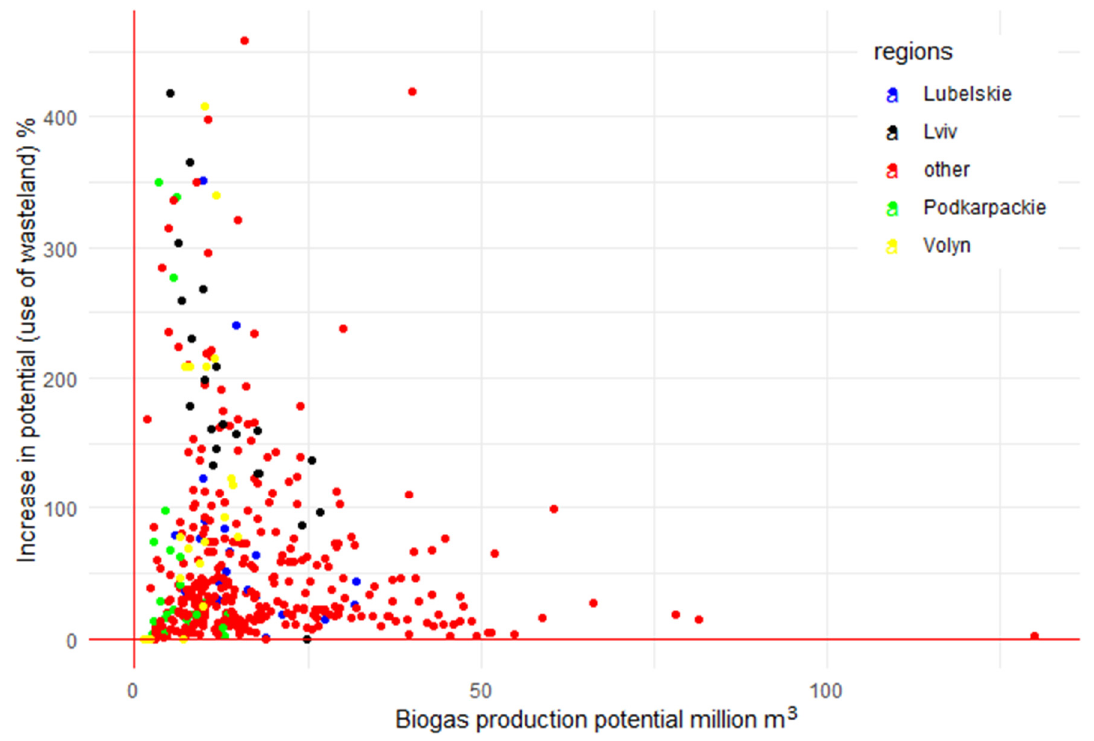
Figure 6. The basic potential of biogas production at the powiat and raion level and the possibility of increasing it based on the cultivation of maize on wastelands. Source: Own study.